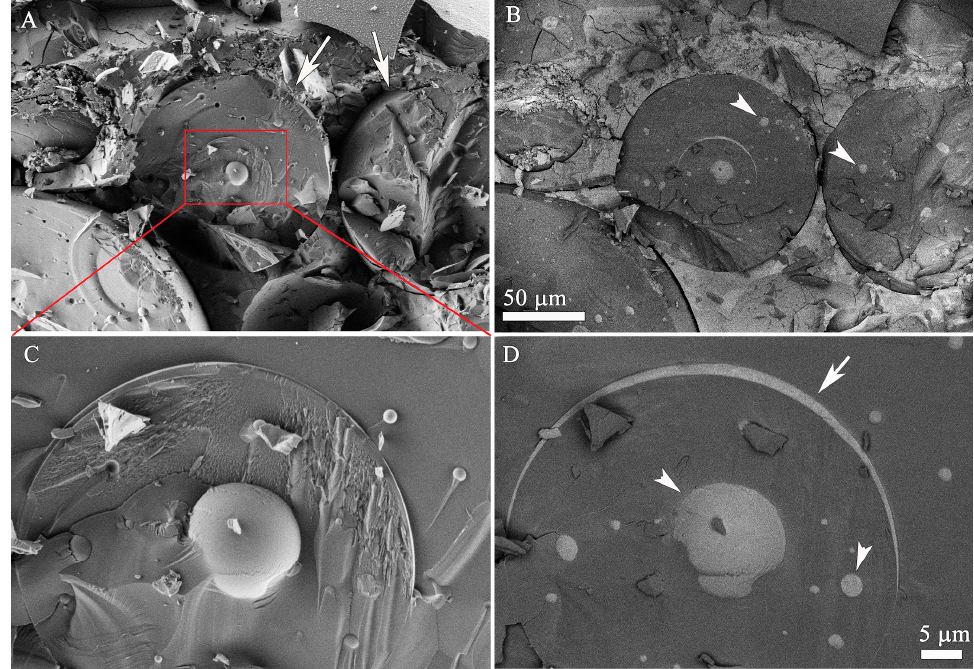
Figure 4. Comparison of the use of ET SEI ( A , C ) vs. the EsB ( B , D ) detector at 1.4 kV in cryo-SEM micrographs of a multiple O/W/O/W emulsion. ( C , D ) show high magnification of the red square area in ( A ). The arrows in ( A ) point at fractured oil droplets. The white arrowheads in ( B ) show water droplets inside the fractured oil droplets. The white arrow in ( D ) points at a thin water layer separating the outer and the inner oil droplets. The white arrowheads in ( D ) show water droplets inside the inner oil droplet. The micrographs were acquired at a temperature of − 145 °C. The spec- imen work distance, WD, was 2.5 mm. Reproduced with permission from Ultramicroscopy [56], 2020.